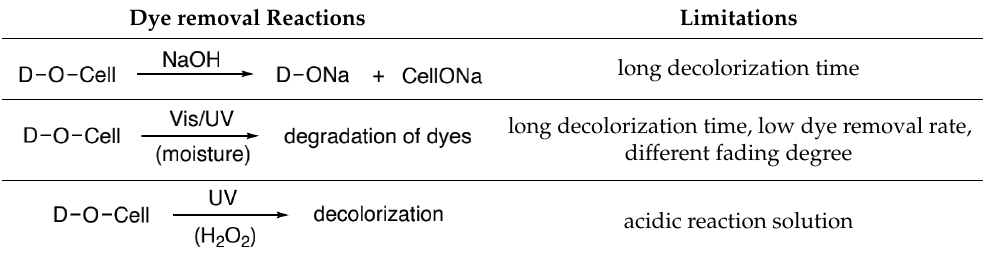
Table 3. Possible ways to remove reactive dyes from cotton [67,89,90].